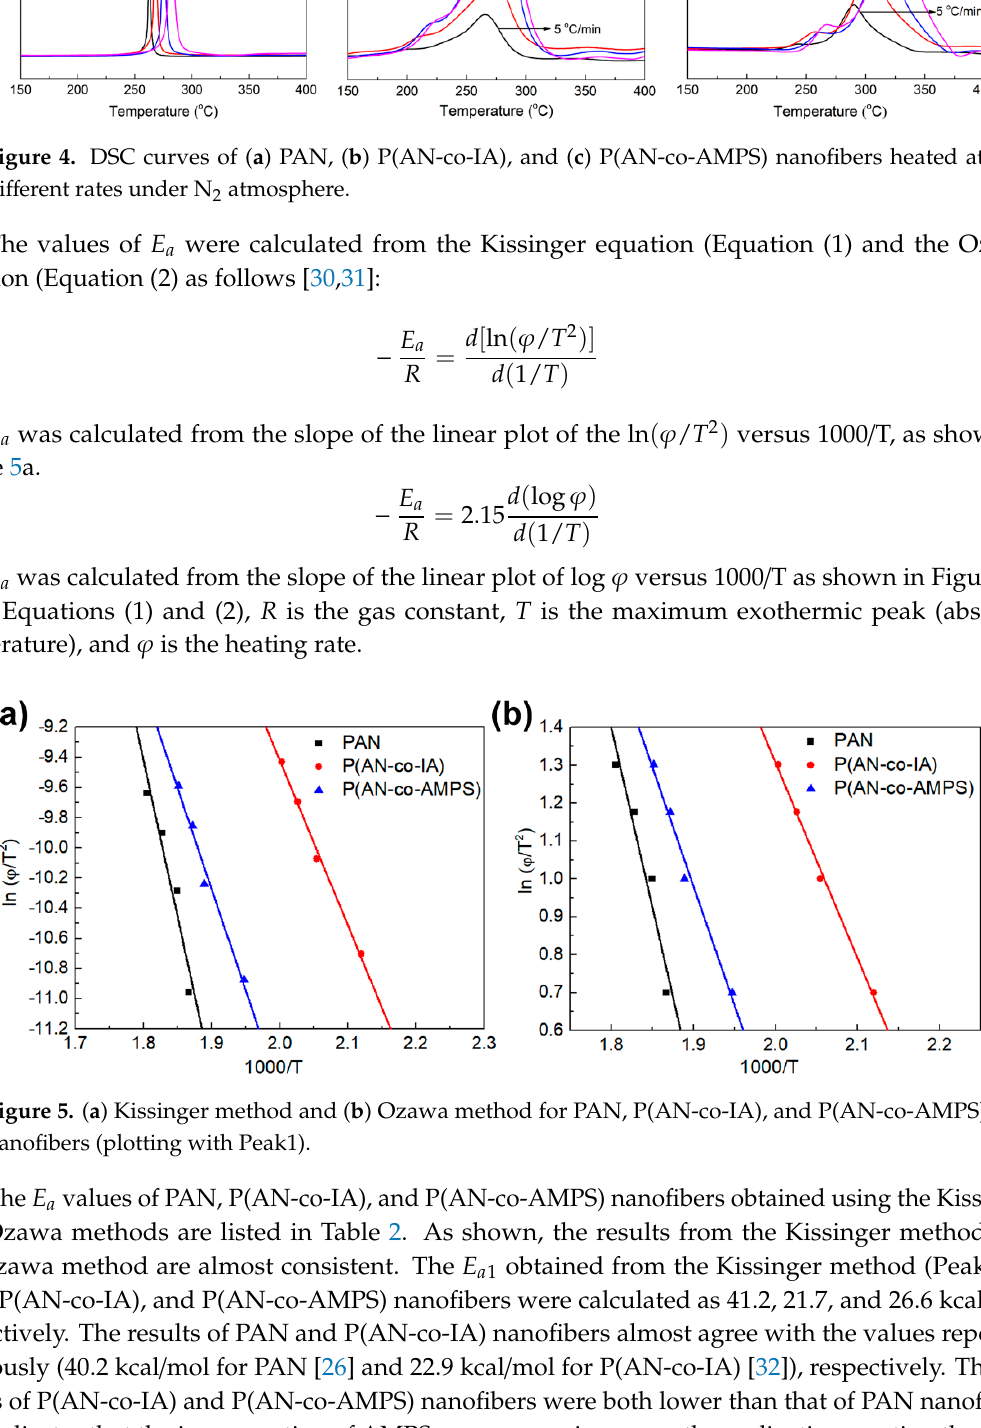
Table 2. Activation energy calculated from Kissinger and Ozawa methods.